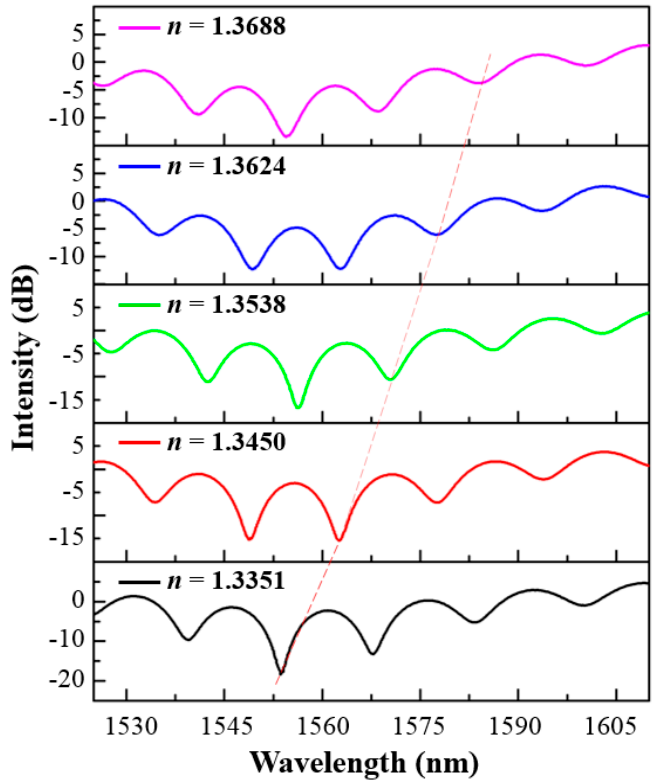
Figure 5. Measured reflection spectra of the optical fiber-tip sensor immersed into liquids with different refractive indices.